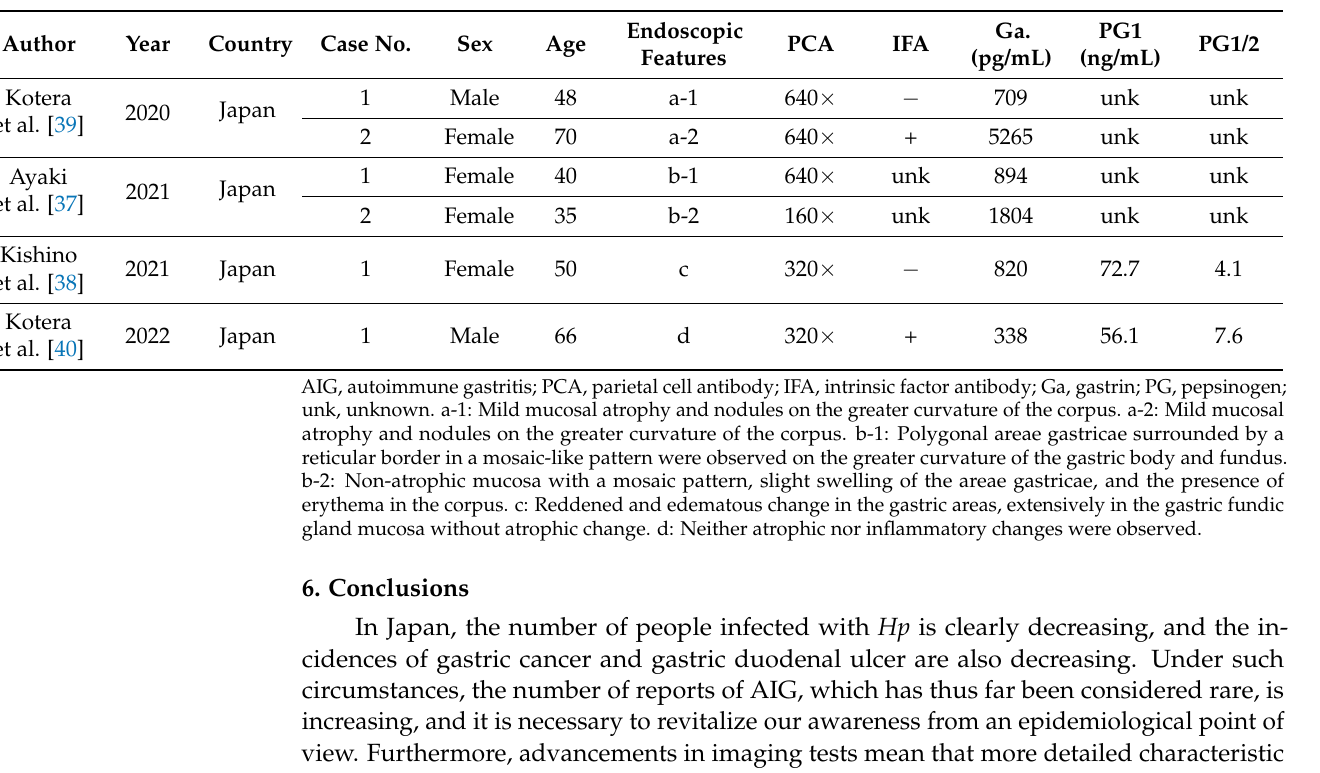
Table 1. Summary of previous reports regarding early